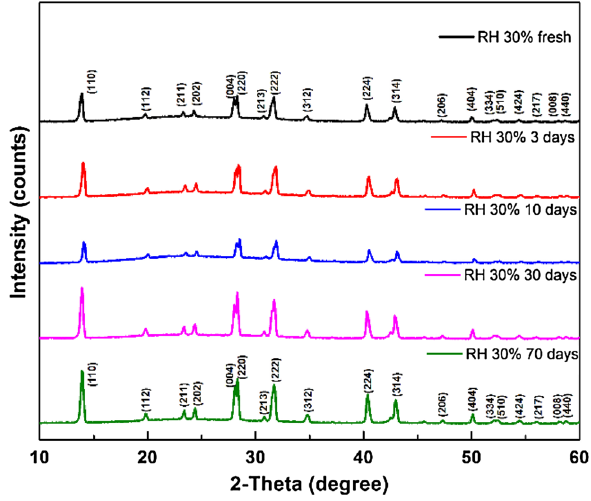
Fig. 3 XRD patterns of fresh perovskite film and stored at RH 30 % for 3, 10, 30, and 70 days. Almost no impurity phases are present